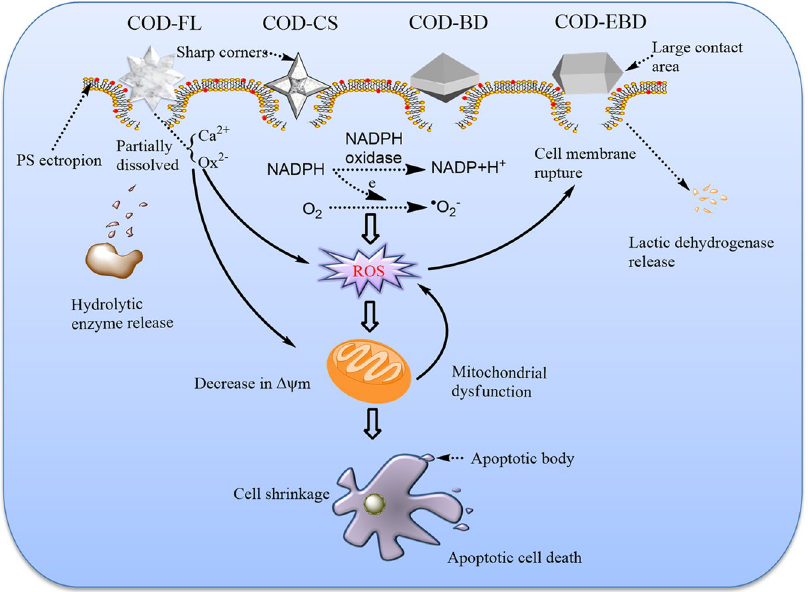
Figure 9. A proposed schematic illustration of the cellular and molecular mechanism of HK-2 cell injury after exposure to varying shapes of COD crystals. Crystals with greater (100) active crystal faces and sharp edges has higher cytotoxicity on renal epithelial